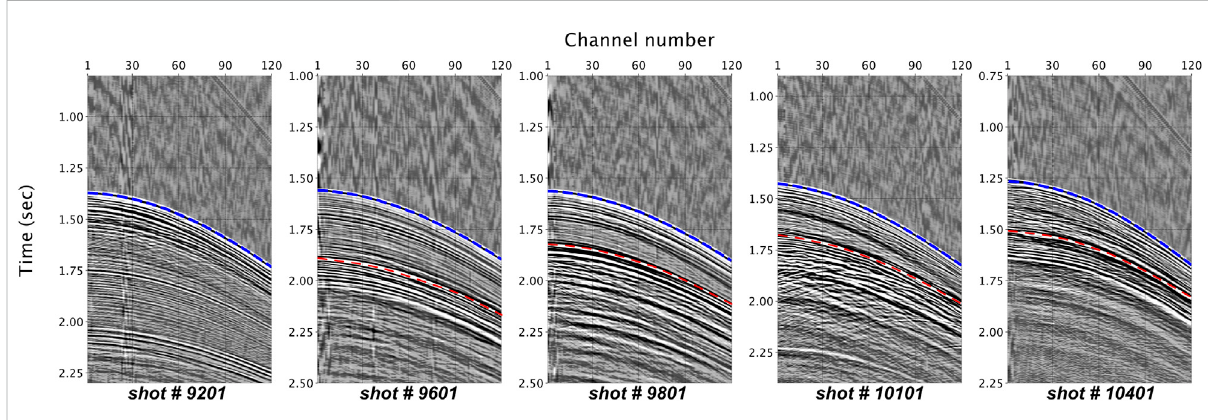
FIGURE 2 Rawshot-gathersonMCS03lines.Thebluedashedlineismarkedonthesea fl oorre fl ections,andthereddashedlineismarkedonthepolarity- reversed re fl